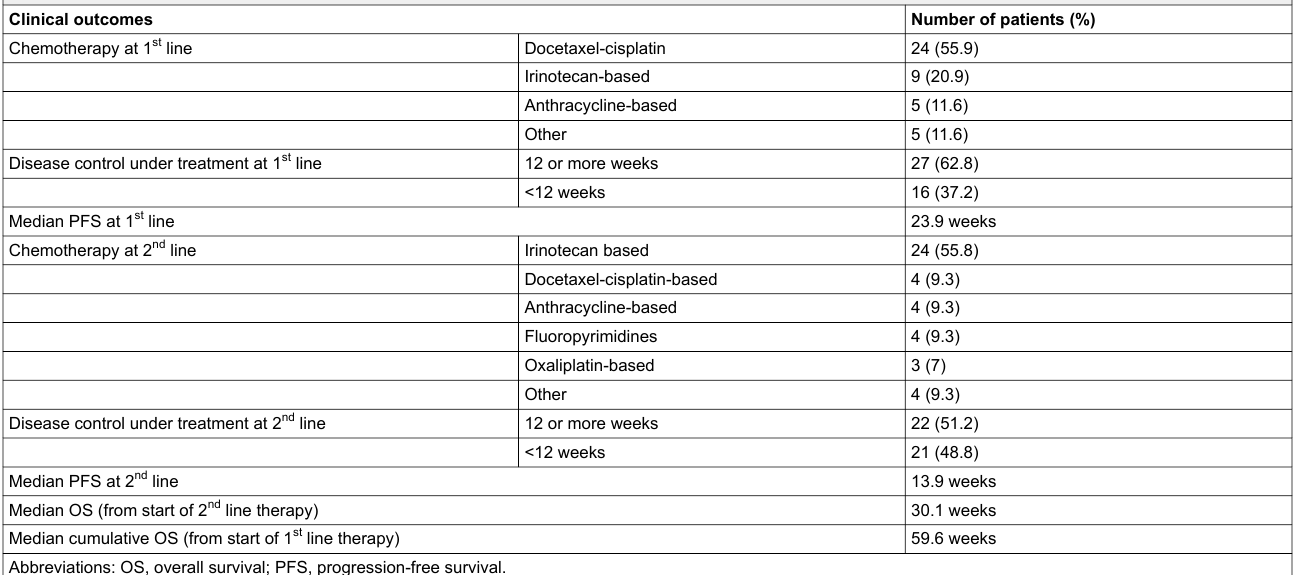
Table 3: Clinical outcomes and treatment regimens for first and second line chemotherapy (n = 43). Clinical outcomes